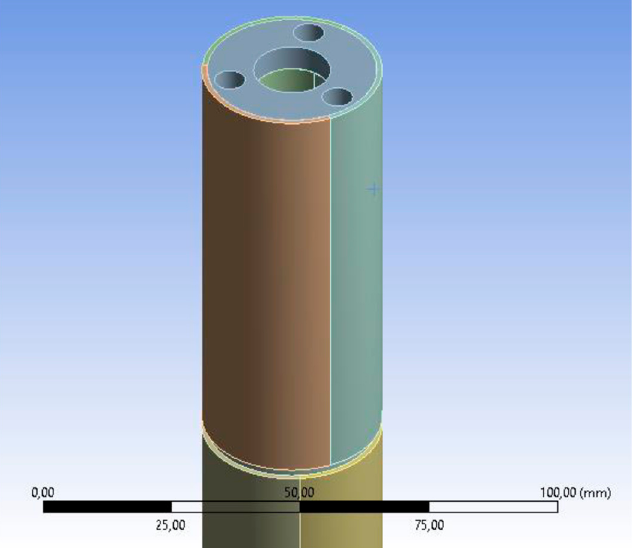
Figure 13. Simpli fi cation of the robot body model. Source: authors.